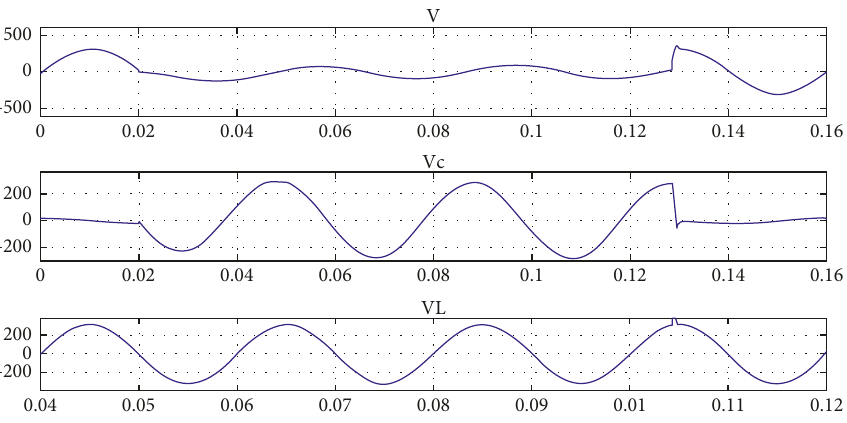
Figure 18: The result of compensating voltage sag.